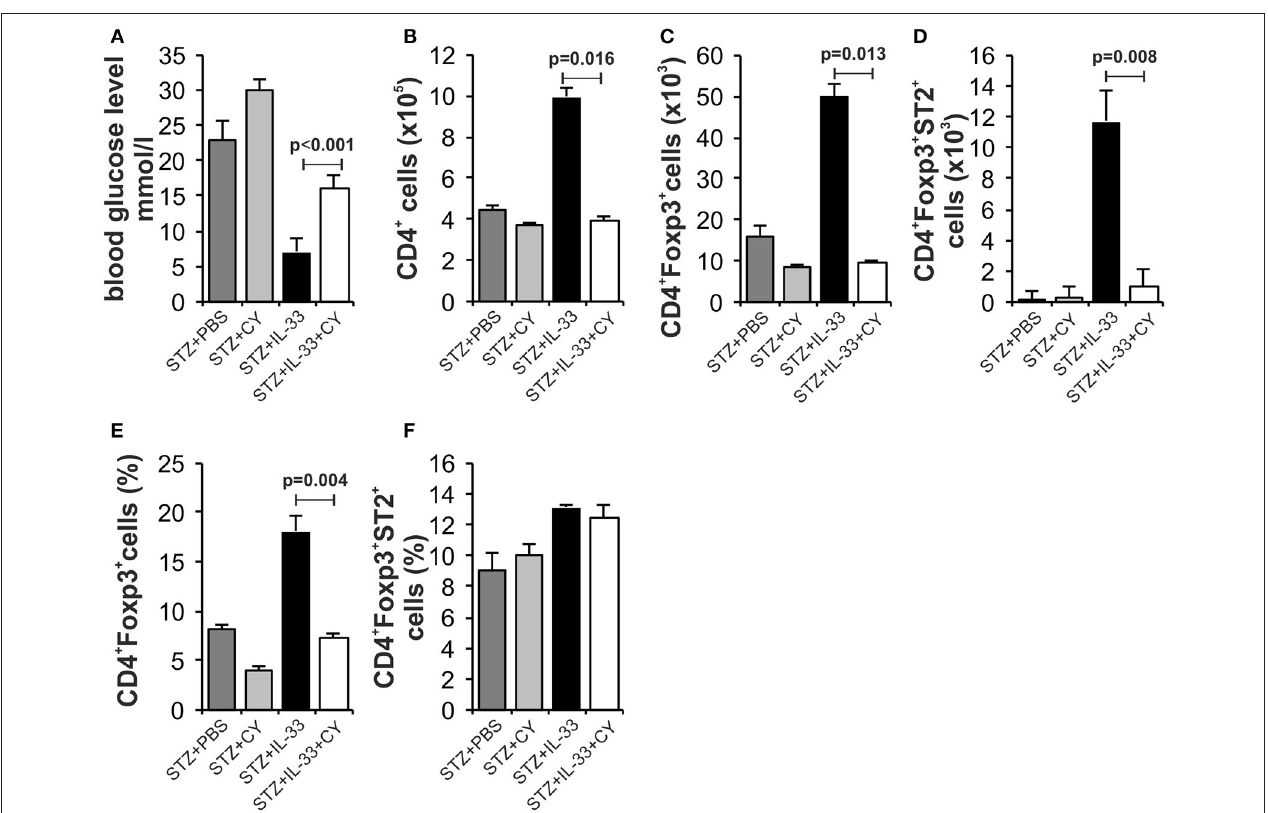
FIGURE 5 | Low dose of cyclophosphamide (CY) affects regulatory cells and attenuates protective effect of IL-33. In order to confirm our hypothesis that the effect of Il-33 administration leads to activation and an increase in the number of regulatory T cells, we added a group that, in addition to MLD STZ and IL-33, also received a low dose of CY (2 × 100 mg/kg) that eliminates regulatory T cells (21). Effect of four injections of 0.4 µ g/mouse IL-33, MLD STZ and CY on glycemia (A) . The number of CD4 + (B) , CD4 + Foxp3 + (C), CD4 + Foxp3 + ST2 + (D) in pancreatic lymph nodes and percentage of CD4 + Foxp3 + (E), CD4 + Foxp3 + ST2 + (F) in pancreatic islets. The animals were treated with MLD-STZ (i.p. 40 mg/kg for 5 consecutive days) with PBS or 0.4 µ g/injection of IL-33 or CY or both. Cells were obtained from pancreatic islets and pancreatic lymph nodes on day 28 after diabetes induction. Data from one experiment with at least 8 mice per group are shown as mean ± SEM; by paired t